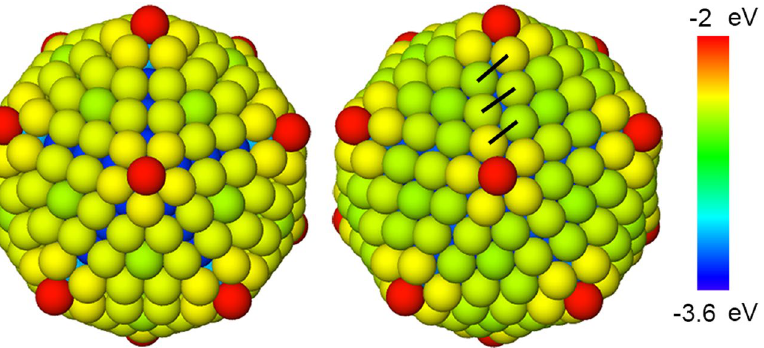
Figure 1. Anti-Mackay icosahedron and chiral icosahedron for Ag according to